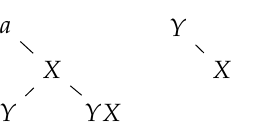
Figure 4. The tree group following the application of ( a , X , λ ) del .